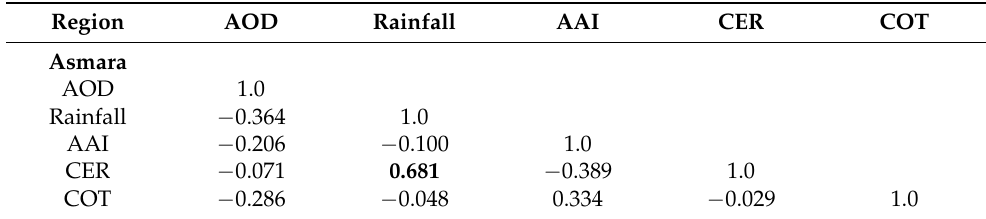
Table 7. The correlation coefficient values between AOD, rainfall, AAI, CER, and COT over Asmara in JJA between 2001 and 2018. The correlation coefficient (R) value ≥ 0.468 (critical R-value) is highlighted in bold.